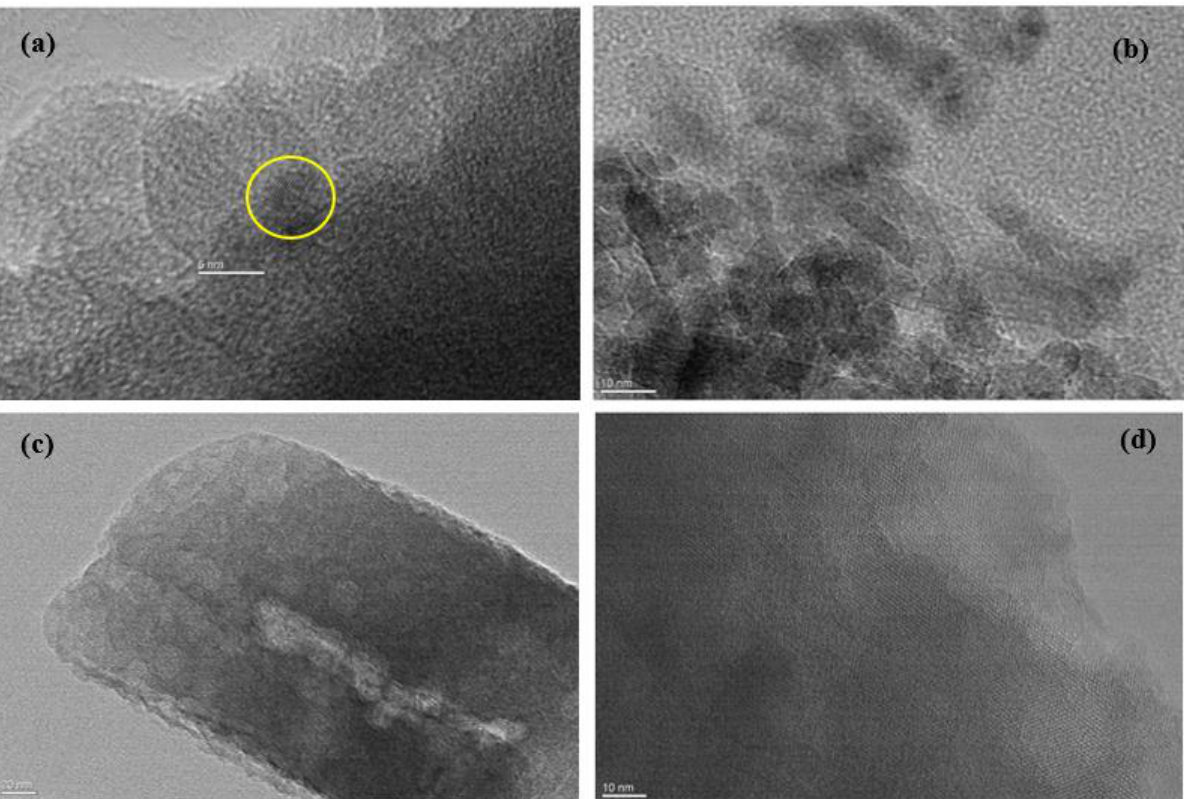
Figure 20. Representative TEM/HRTEM images of ( a ) SiO 2 -CH-Ni-oc-1 (1000 ppm Ni), ( b ) Al 2 O 3 - CH-Ni-oc-2 (2500 ppm Ni), ( c ) USY-CH-Ni-oc-1 (1000 ppm Ni), and ( d ) USY-CH-Ni-oc-4 (10,000 ppm Ni).